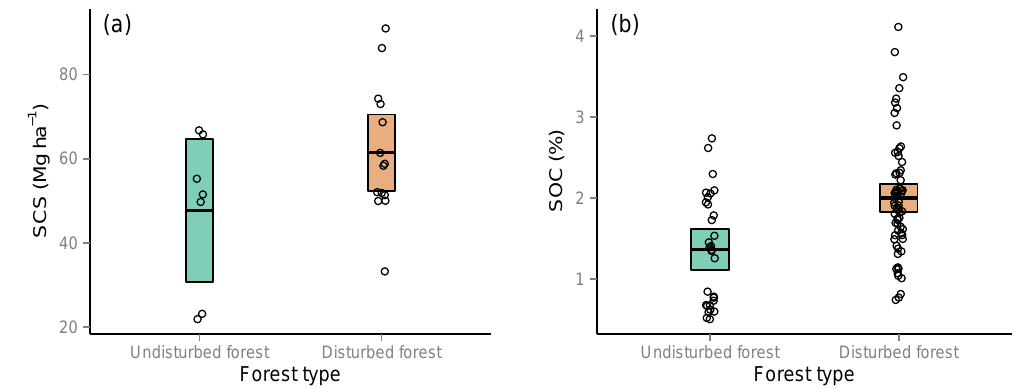
Figure 2. Comparison of the entire 0–30cm depth profile for (a) soil carbon stock (SCS) and (b) soil organic carbon (SOC) between the disturbed and the undisturbed forest (mean ± 95% confidence interval) at 0–30cm depth profile.